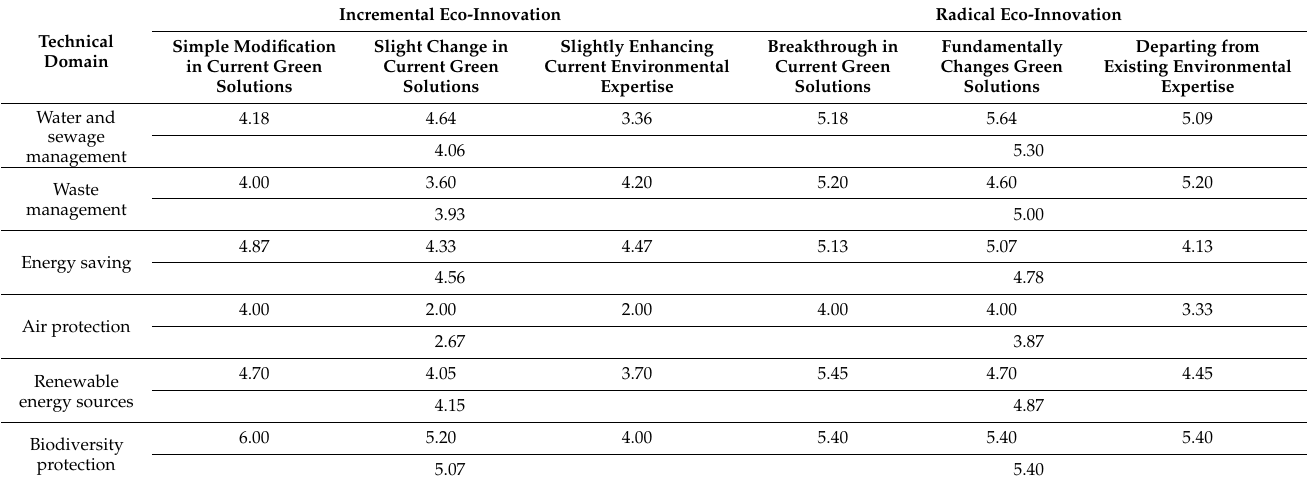
Table 1. Propensity to generate eco-innovation by the technological